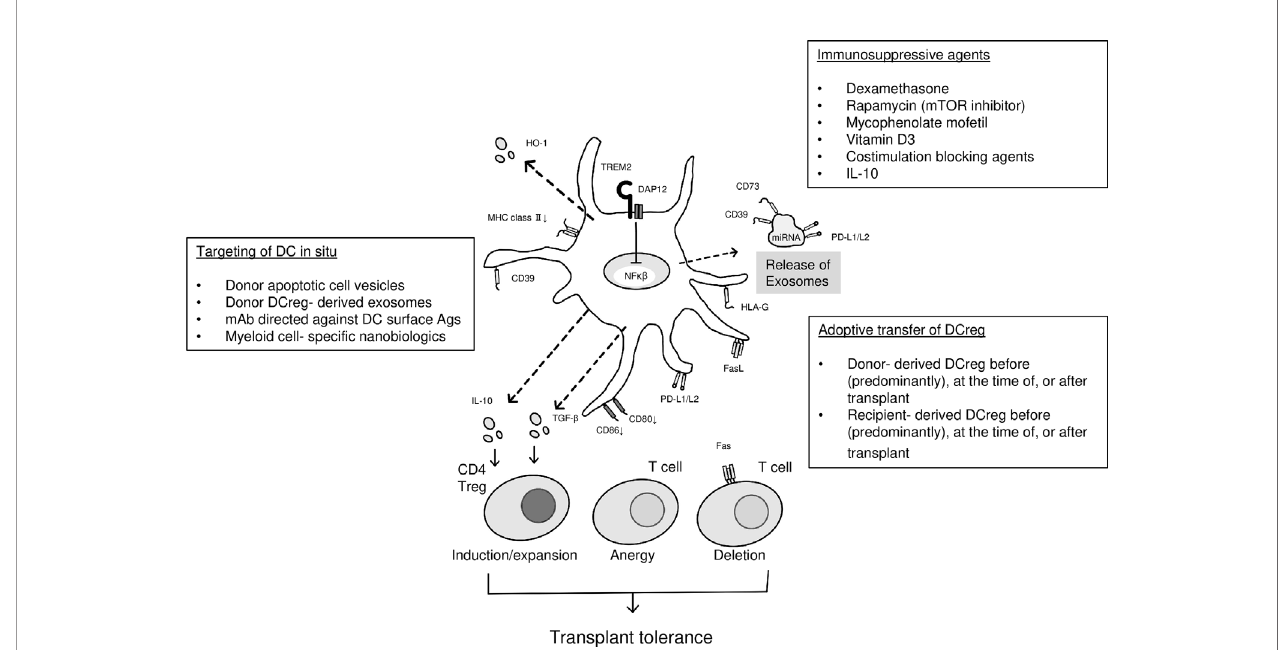
FIGURE 1 | DCreg and promotion of their function. Center, DCreg showing cell membrane-expressed and secreted/molecules and released small extracellular vesicles (exosomes) that can regulate T cell responses and immune reactivity; left panel, approaches to targeting of DCreg in situ ; upper right panel, use of immunosuppressive agents that promote DC tolerogenicity; lower right panel, adoptive transfer of DCreg in transplant recipients. DAP12, DNAX activating protein of 12 kDa; HO-1, hemoxygenase-1; PD-L1/2, programed death ligand1/2; miRNA, microRNA; TGFB, transforming growth factor beta; TREM2; triggering receptor expressed on myeloid cells